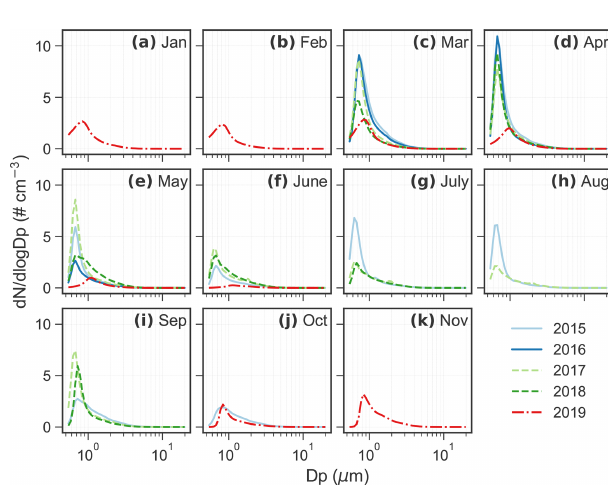
Figure A1. Monthly average aerosol number size distribution from 2015 to 2019. There are missing data in some months but good data coverage from March to June. No data are available in December.